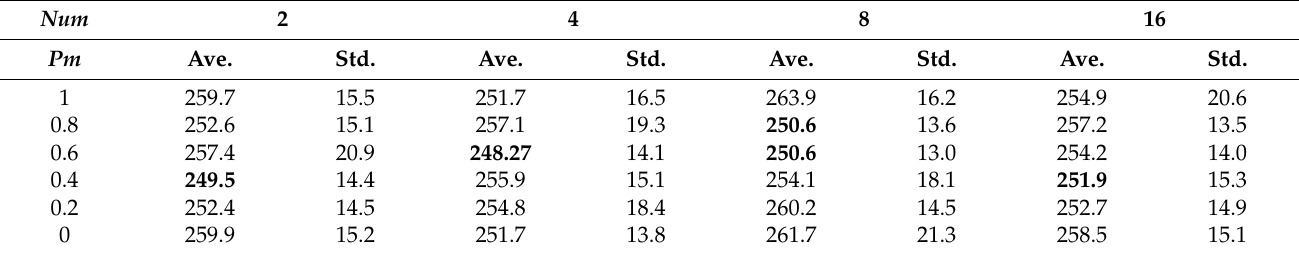
Table 8. Objective function value with different P m in scenario 2.